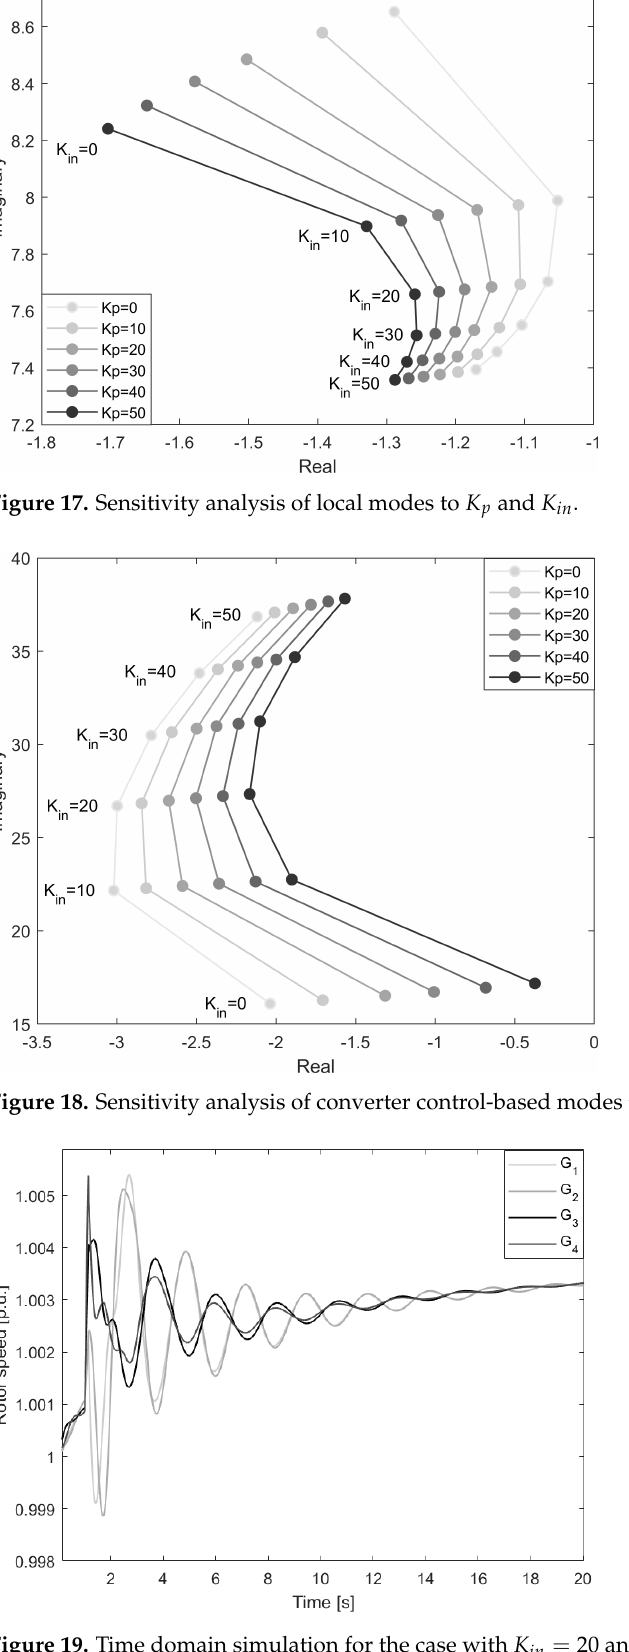
Figure 19. Time domain simulation for the case with K in = 20 and K p =